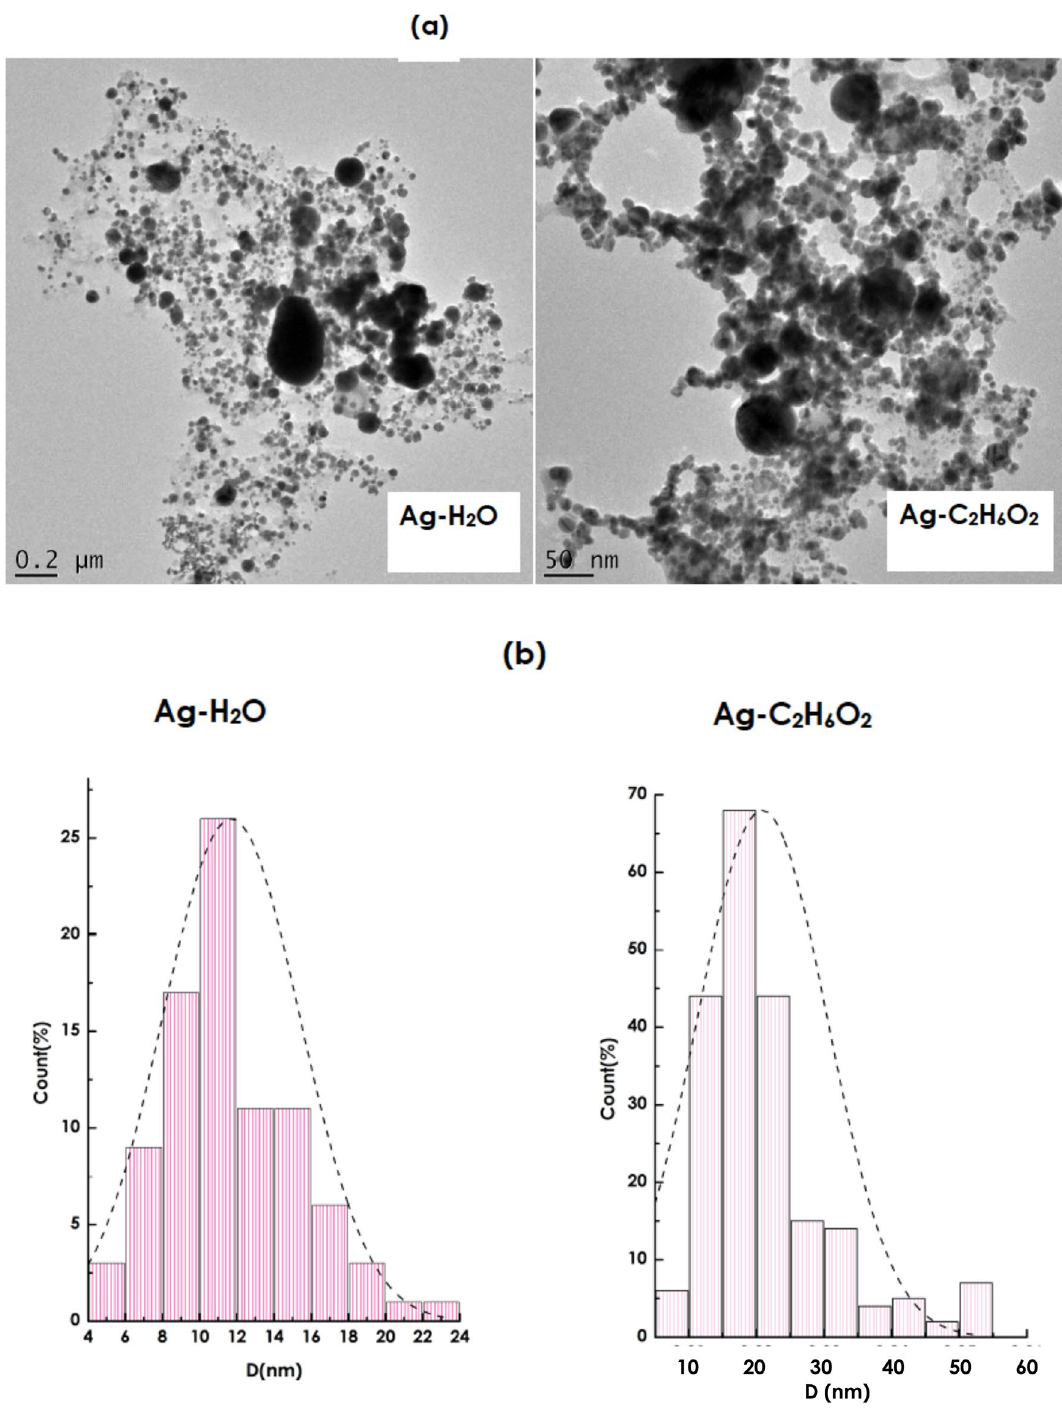
Figure 3. ( a ) Transmission electron microscopy images of the Ag nanoparticles in H 2 O and C 2 H 6 O 2 , ( b ) size distribution of the synthesized Ag nanoparticles by radiolysis in H 2 O and C 2 H 6 O 2